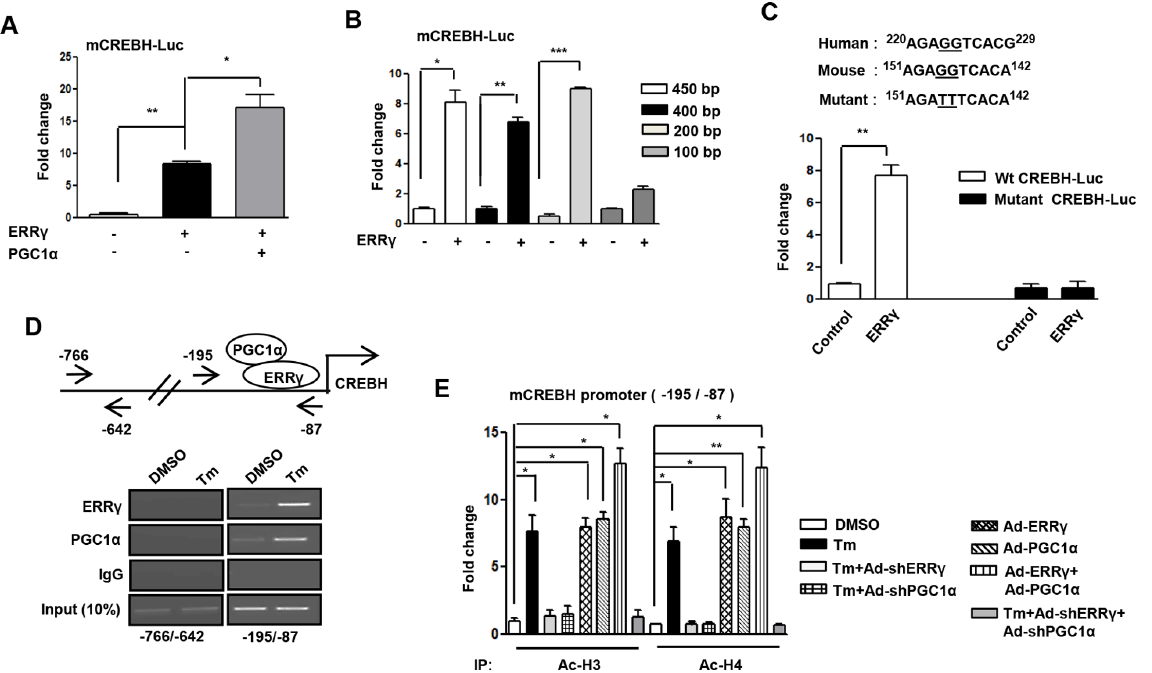
Fig 3. ERR γ regulates activation of CREBH gene promoter. (A), PGC1 α -dependent activation of the mouse CREBH promoter by ERR γ . Transient transfection was performed in 293T cells with the indicated plasmid DNAs. (B), Deletion constructs of the CREBH promoter demonstrate the ERR γ binding site in 293T cells. Transient transfection was performed in 293T cells with the indicated plasmid DNAs. (C), ERRE-dependent activation of the CREBH promoter in 293T cells. 293T cells were transfected with the wild-type or ERRE-mutant CREBH promoter along with ERR γ plasmid DNAs. (D), ChIP assay shows the binding of ERR γ and PGC1 α to the endogenous CREBH promoter by semiquantitative PCR. AML12 cells were treated with DMSO or Tm (5 μ g/mL) for 12 hr. After completion of the treatment, chromatin fragments were prepared and immunoprecipitated with ERR γ , PGC1 α , or IgG control antibodies. DNA fragments covering – 766 to – 642 and – 195 to – 87 elements on the CREBH promoter were PCR amplified. 10% of the soluble chromatin was used as input. (E), ChIP assay for detection of histone acetylation at the ERR γ /PGC1 α binding site under the indicated conditions in AML12 cells. Chromatin fragments were prepared and immunoprecipitated with Acetyl-Histone 3 and Acetyl-Histone 4 antibodies. DNA fragments covering – 195 to – 87 element on the CREBH promoter were qPCR-amplified as described in the ‘ Materials and Methods ’ section. Data are representative of three independently performed experiments and shown as mean ± SD; * P < 0.05, ** P < 0.005, and *** , p < 0.0005 using Student ’ s